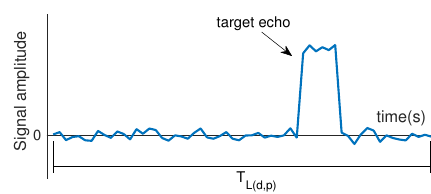
Figure 6. Noisy signal typically received during a given listening period T L ( d , p ) .